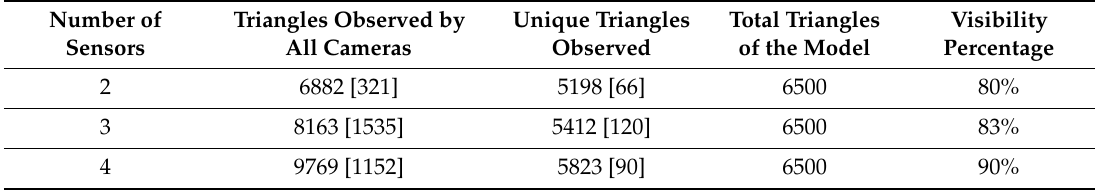
Table 11. Visibility results in terms of triangles observed with an increasing number of sensors observing the